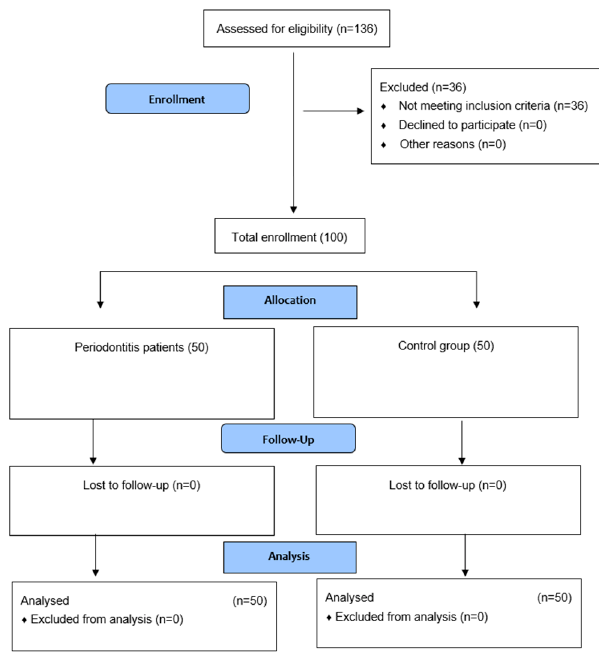
Figure 1. Consort flow diagram.